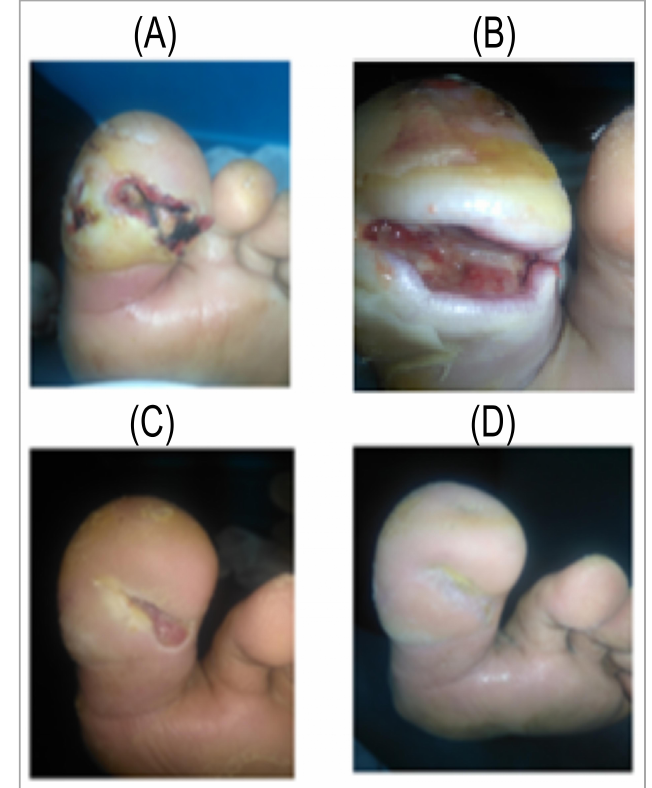
Figure 1. Randomized controlled trials of honey. (A) gangrenous part of wet type of diabetic foot need to mechanical debridement. (B) Wound with little necrotic tissue after dressing by honey. (C) Wound decrease in size. (D) wound covered by skin and